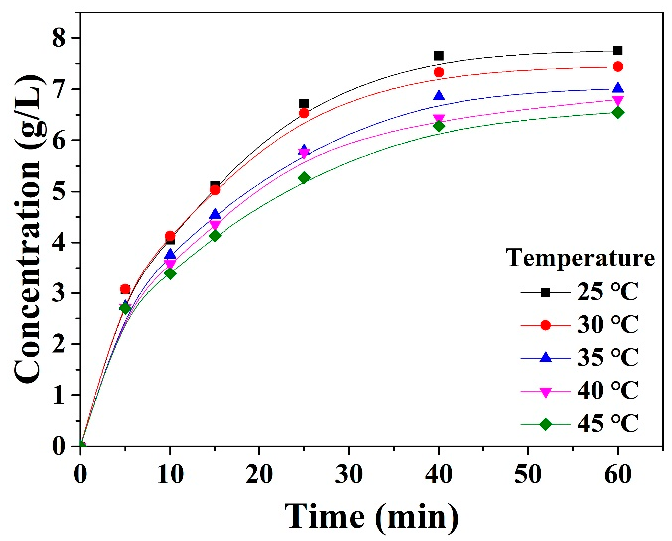
Figure 5. Effect of temperature on carbonization reaction [liquid-solid ratio = 20, flow rate of CO 2 = 3 L/min].